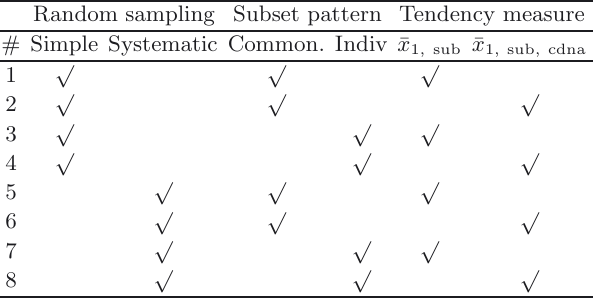
Table 5. St. Dev. of the mean values μ assy , adj